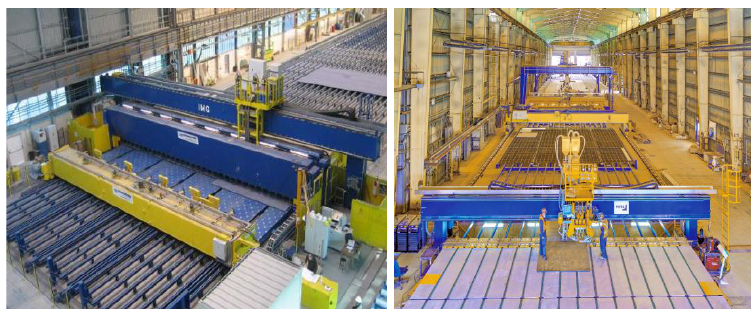
Figure 8. Welding work environment in heavy industries. J. Mar. Sci. Eng. 2020 , 8 , x FOR PEER REVIEW